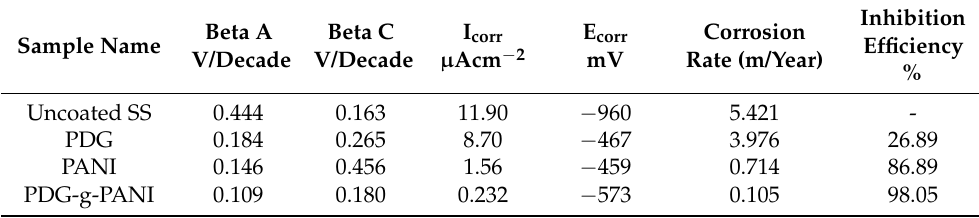
Table 3. Comparison of essential corrosion kinetic parameters of uncoated SS, PANI-coated, and PDG-g-PANI-coated SS in 3.5% NaCl